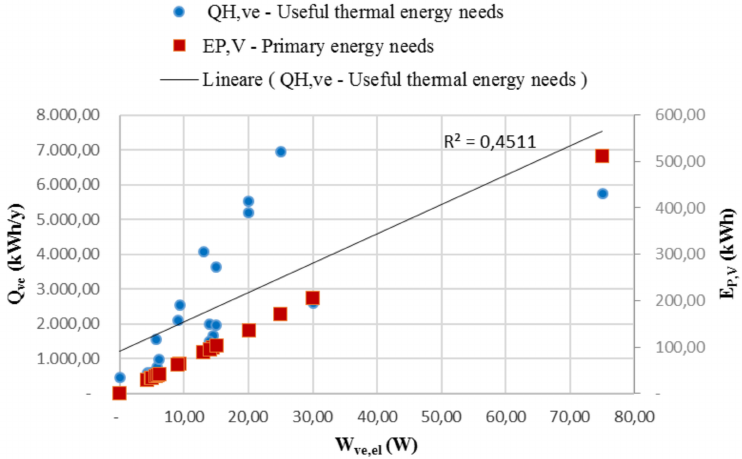
Figure 4. Relationship between Q H,ve , E P,V e W. NB: all the figures use dots and commas as per Italian